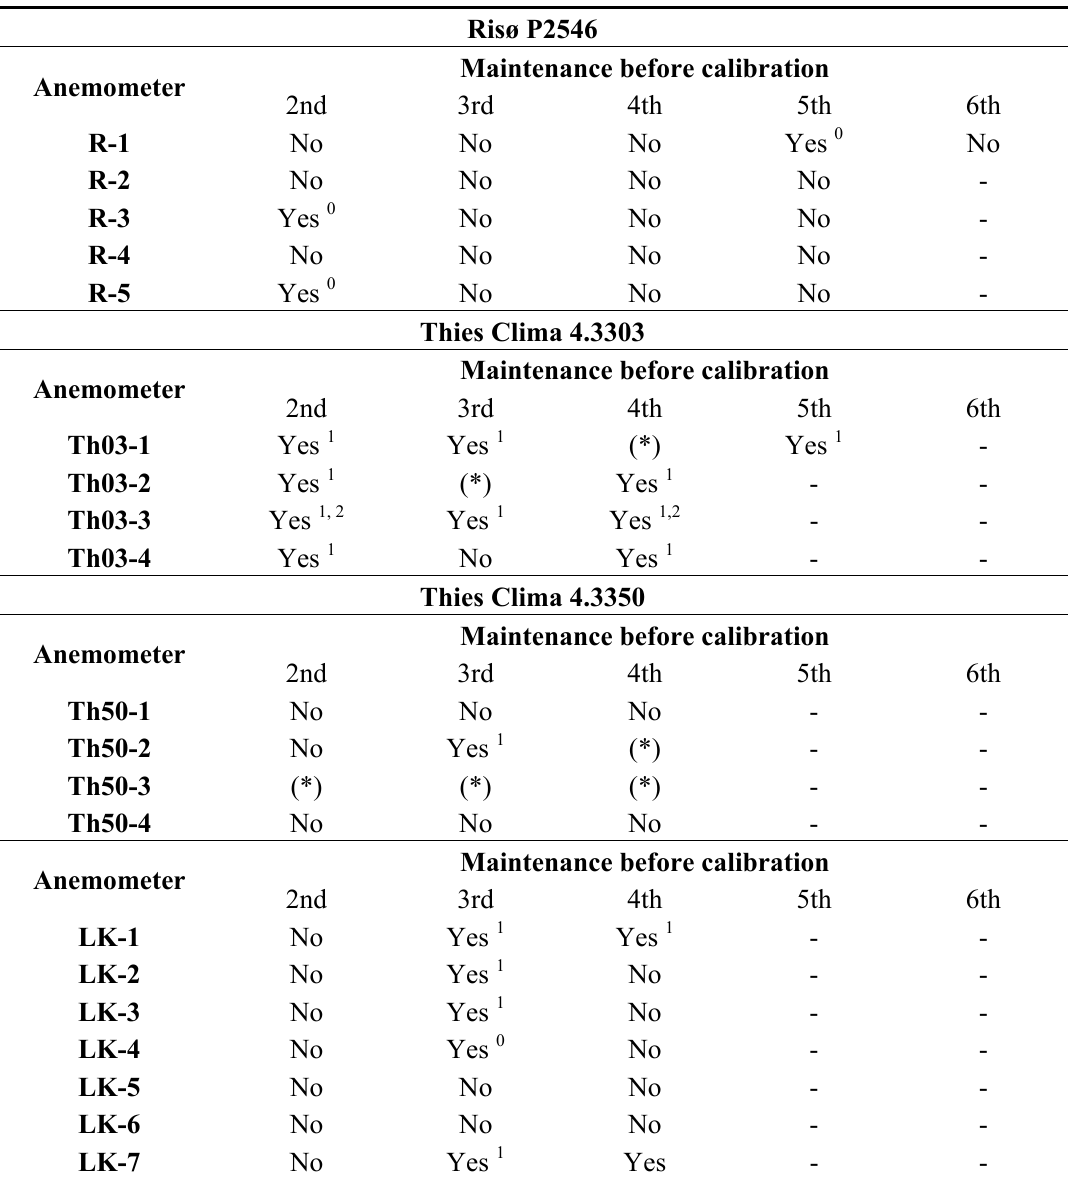
Table 8. Maintenance works performed on the more times calibrated anemometers at the IDR/UPM Institute in the studied period of